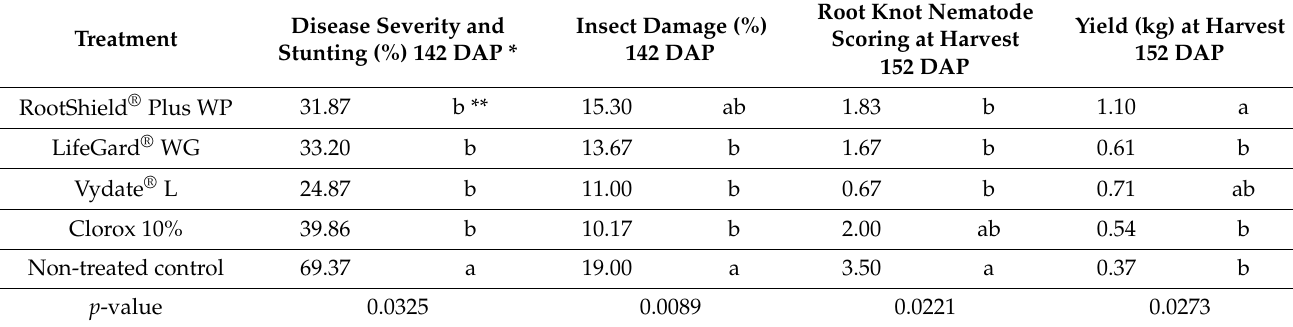
Table 1. Efficacy of the two biocontrol products, a nematicide/insecticide and a disinfectant soil- drenched in the study to mitigate seed- and diseases on ginger grown in the high tunnel in 2019.